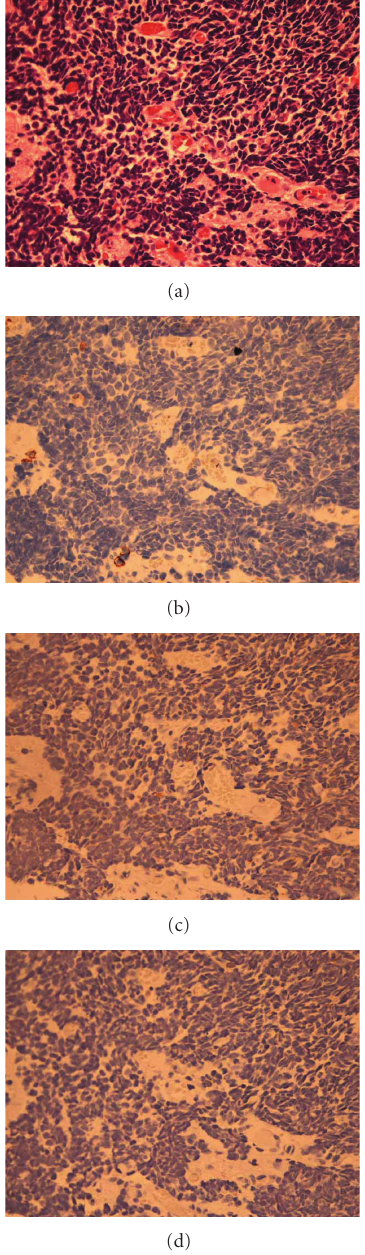
Figure 3: Histopathological examination by HE staining (a) reveals cluster of undi ff erentiated small cells. Immunohistochemical anal- yses of LCA (b), EMA (c), and chromogranin A (d) show no significant positive staining (original magnification; ×